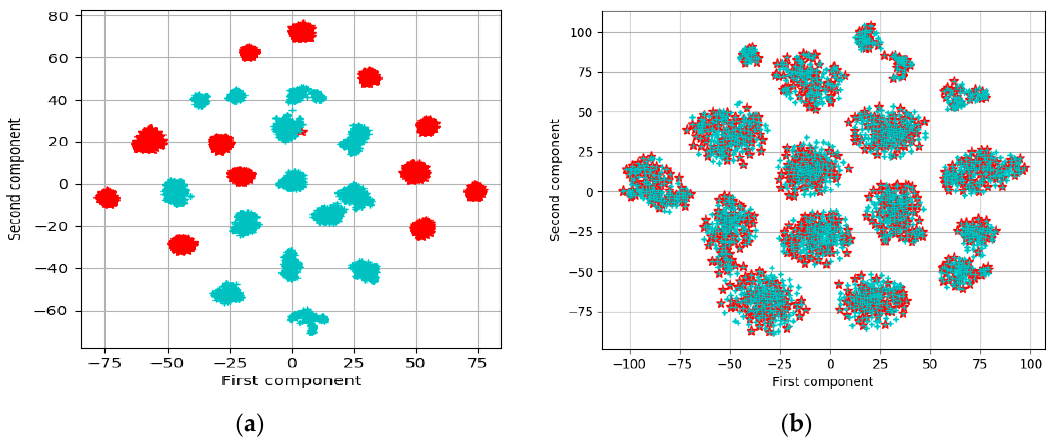
Figure 8. t-SNE representation of the source and target features obtained at the output of the hidden average layer for the scenario ( S AID , S Merced , S NWPU ) → T PatNet when ( a ) using the L ce loss, and ( b ) the total loss L = L ce + L h + L o . (blue: source domain, red: target domain).